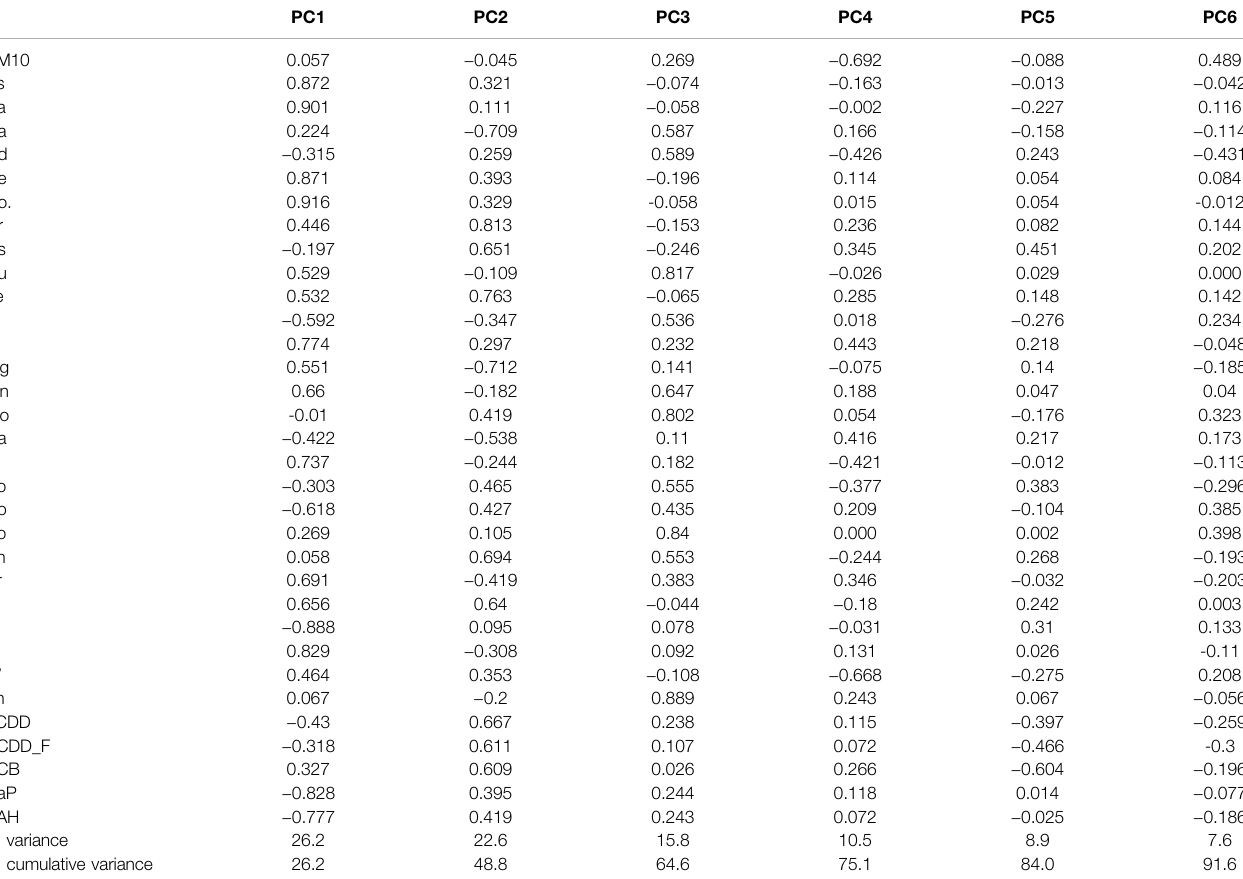
TABLE 1 | Principal Component Analysis (PCA).Rotated component matrix and variance explained. PC1